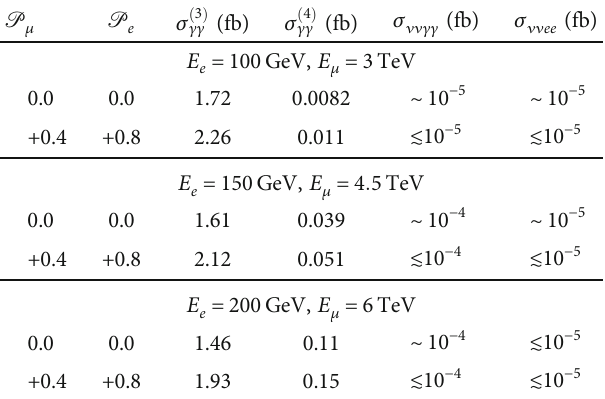
Table 6: Cross sections in fb for the signal processes (14) obtained from the operator Q , see equation (6) and Figure 1(a); (14) eA , see equation (7) and obtained from the operator Q eAA Figure 1(b); and the background processes (15) and (16). All cross sections, at the three energies shown, obtained at the detector-simulation level with cuts C from 0 − 3